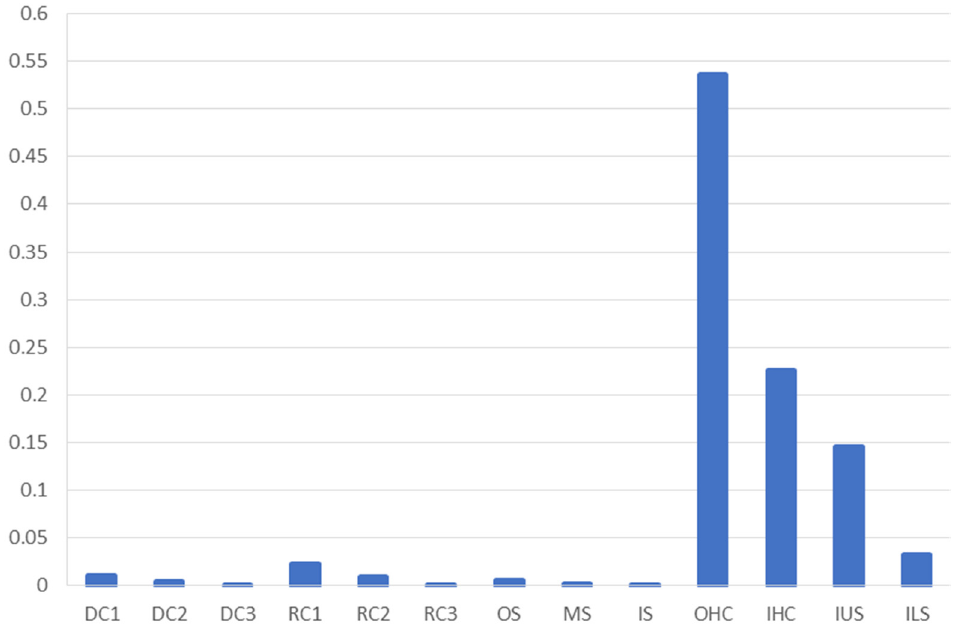
Figure 6. Importance coefficients of each type of Cable ‐ Strut